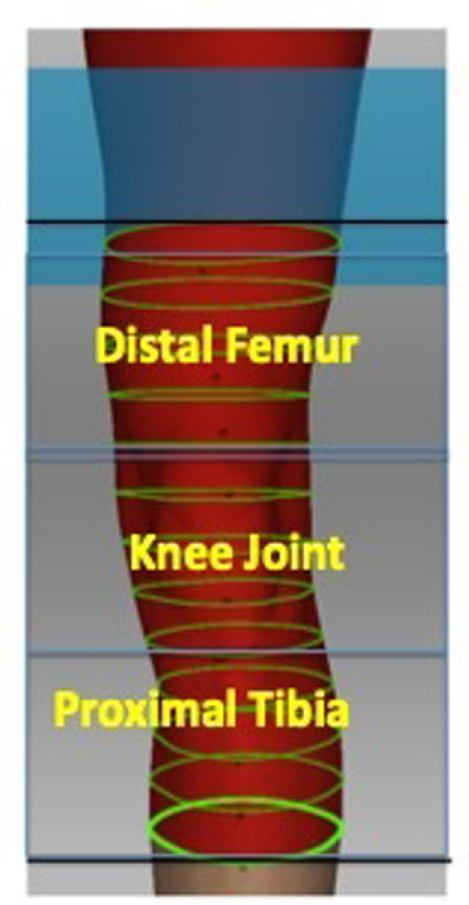
Fig 3. Region of interest. Determination of the three volume regions of interest (ROI). Distal Femur: from the top of the patella to 10 cm proximal from that (Volume 1–4), Knee Joint: from the top of the patella to the tuberositas tibiae (Volume 5–8), Proximal Tibia: from the tuberositas tibiae to 10 cm distal from that (Volume 9–12).